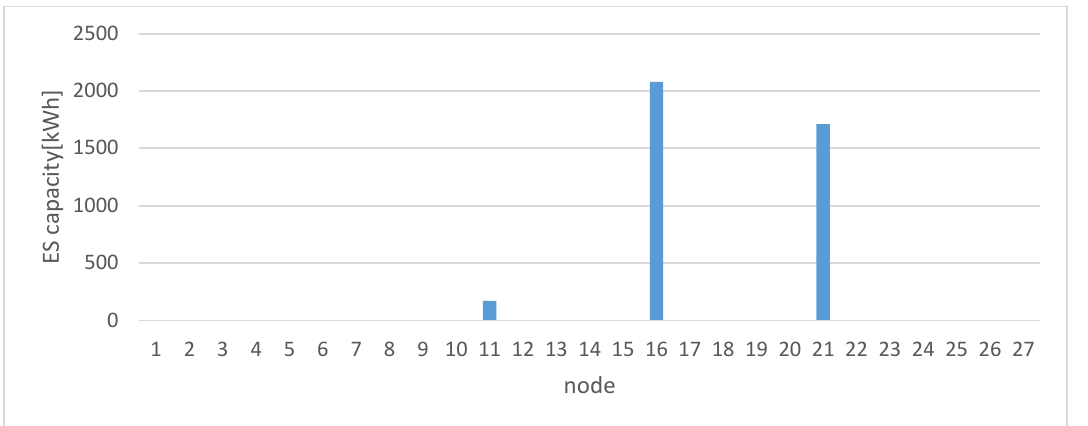
Figure A3. Capacity structure for scenario “2”.